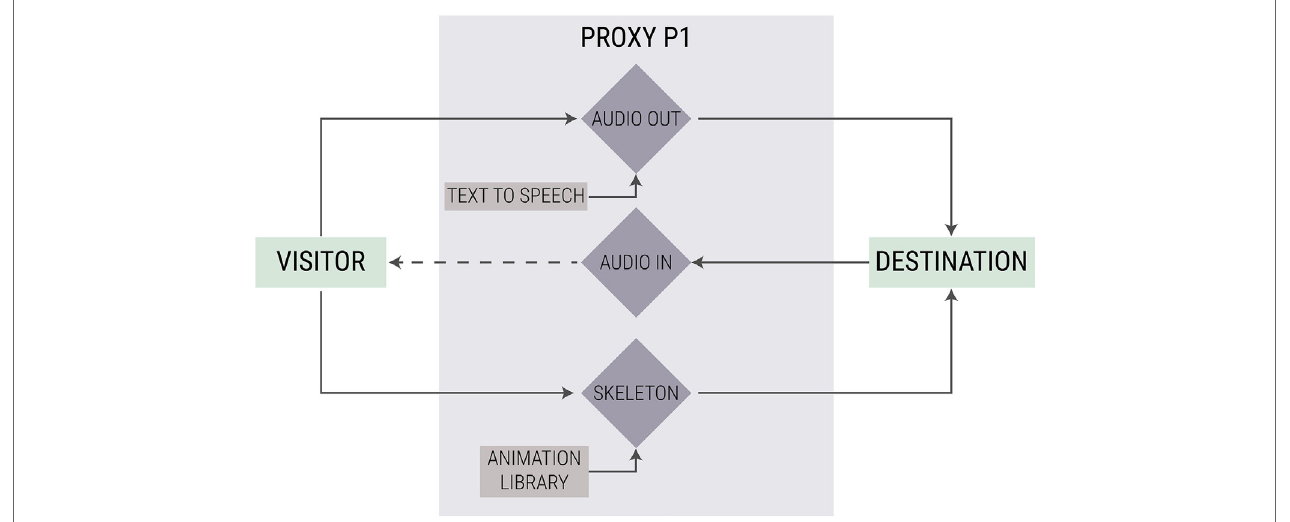
FigUre 1 | a simplified schematic diagram of the configuration of one of the proxies: (i) a switch decides whether to transmit the visitor’s voice or an automatically generated text, (ii) a switch decides whether to transmit the audio from the destination to the visitor or not, and (iii) a switch decides whether to transmit the visitor’s movements or automatically generated animation to the remote representation